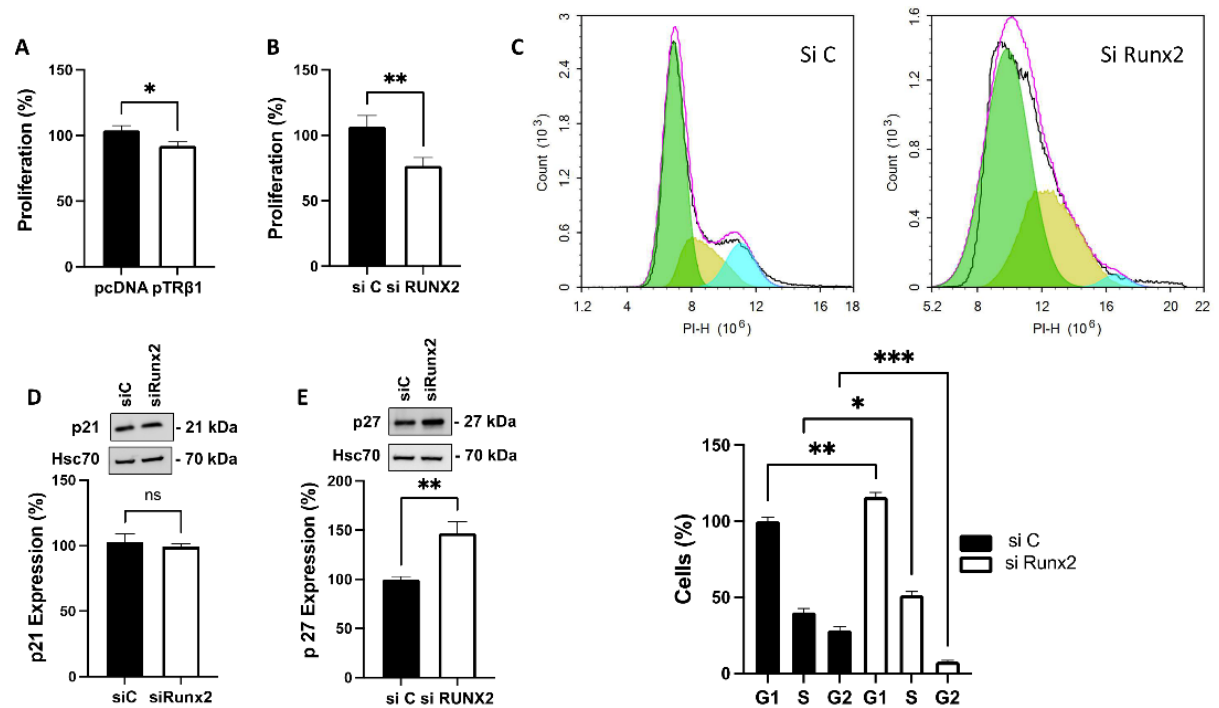
Figure 4. TR β 1 and Runx2 regulate the proliferation of thyroid cancer ML-1 cells. ( A ), Overexpression of TR β 1 (pTR β 1) decreased the proliferation of ML-1-cells after 48 h. The bar diagram shows the mean ± SEM ( n = 3). * p < 0.05 . ( B ), Silencing Runx2 (siRunx2) decreased the proliferation of ML-1 cells after 48 h. The bar diagram shows the mean ± SEM ( n = 3). ** p < 0.01. ( C ), Runx2 knockdown decreased the proliferation of ML-1 cells by prolonging G 1 , S phases and a decrease in G 2 phase of cell cycle. The bar diagram shows the mean ± SEM ( n = 3). * p < 0.05, ** p < 0.01, *** p < 0.001. ( D ), Runx2 knockdown has no effect on p21 protein expression. A representa- tive Western blot is shown. Hsc70 was used as a loading control. The bar diagram shows the mean ± SEM ( n = 3). ns = not significant. ( E ), Runx2 knockdown increased p27 protein expression. A representative Western blot is shown. Hsc70 was used as a loading control. The bar diagram shows the mean ± SEM ( n = 3). ** p < 0.01.